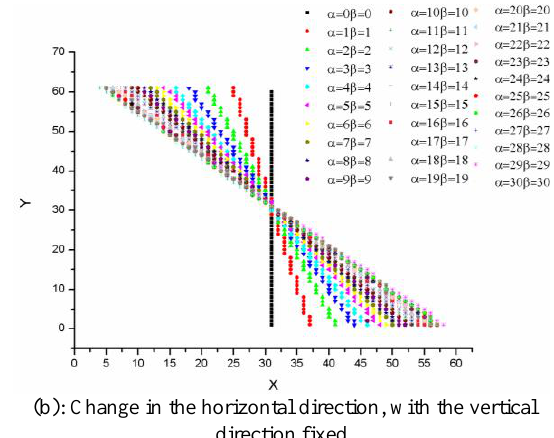
Figure 4. Optimal distribution of the echo signal peak value in different slope gradients.